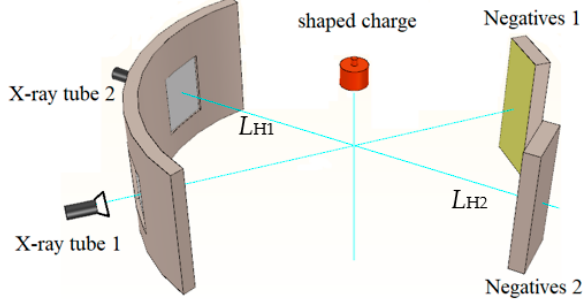
Figure 18. Field arrangement of pulse x-ray photography test and SCS liner.